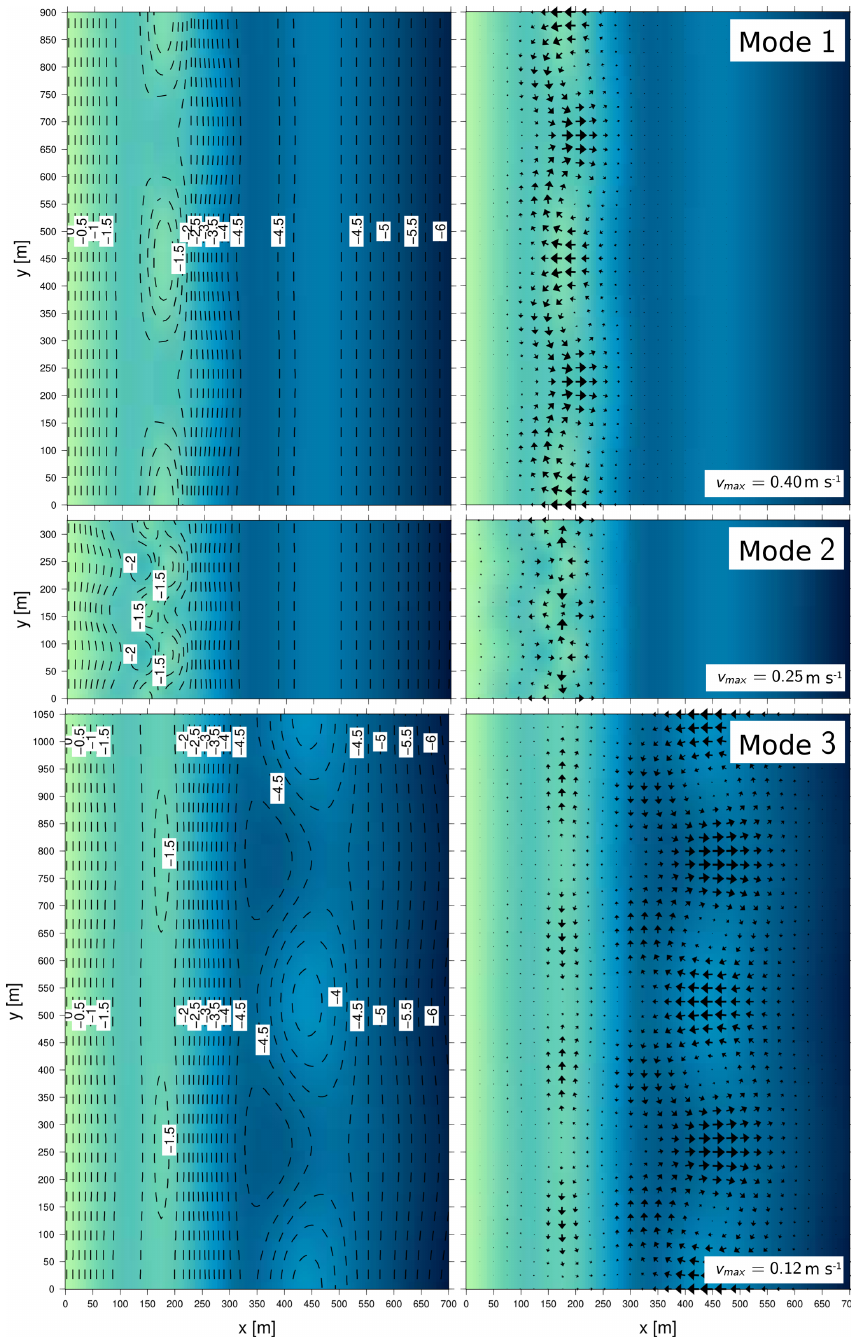
Figure 5. Fastest growing modes for the peaks in the growth rates shown in Fig. 4. The water depth (left) and depth-averaged currents (right) of each of the three modes are shown for bottom perturbations of 0.5m of amplitude. The maximum velocities are indicated for each mode.